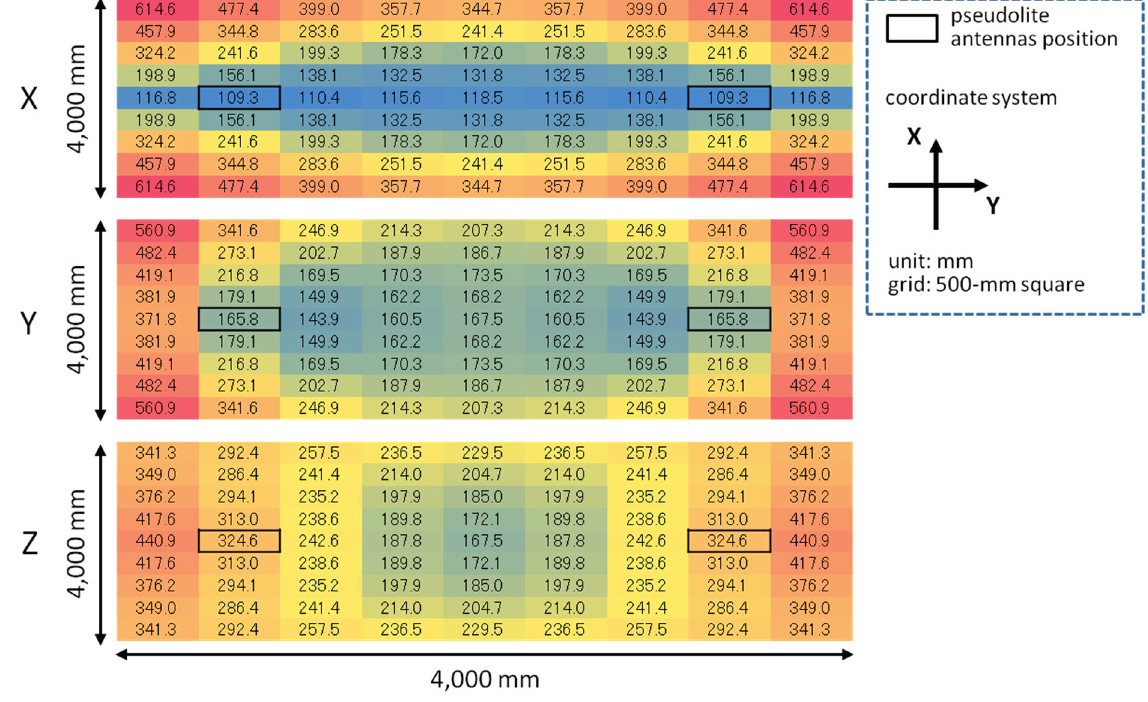
Figure 12. Error simulation results for each of x -, y -, and z -coordinates with double array. The error of three-dimensional positioning for each x , y , and z -coordinate was simulated using Equations (15)–(17) based on the geometric relation between pseudolite antenna arrays and measurement positions (receiver antenna positions) shown in Figure 10 and the average CPD error